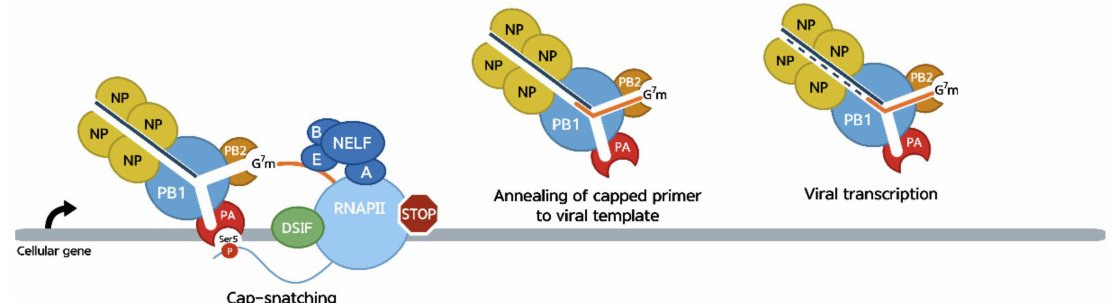
Figure 3. The IAV RdRp interacts with the paused RNAP II through its PA and PB2 subunit. The PA subunit binds Ser5-P on the CTD, opening the cap-binding domain of PB2. Once the cap structure is bound by PB2, the endonuclease domain of PA cleaves the nascent pre-mRNA, which is then inserted in the catalytic center of PB1 and extended using the vRNA as a